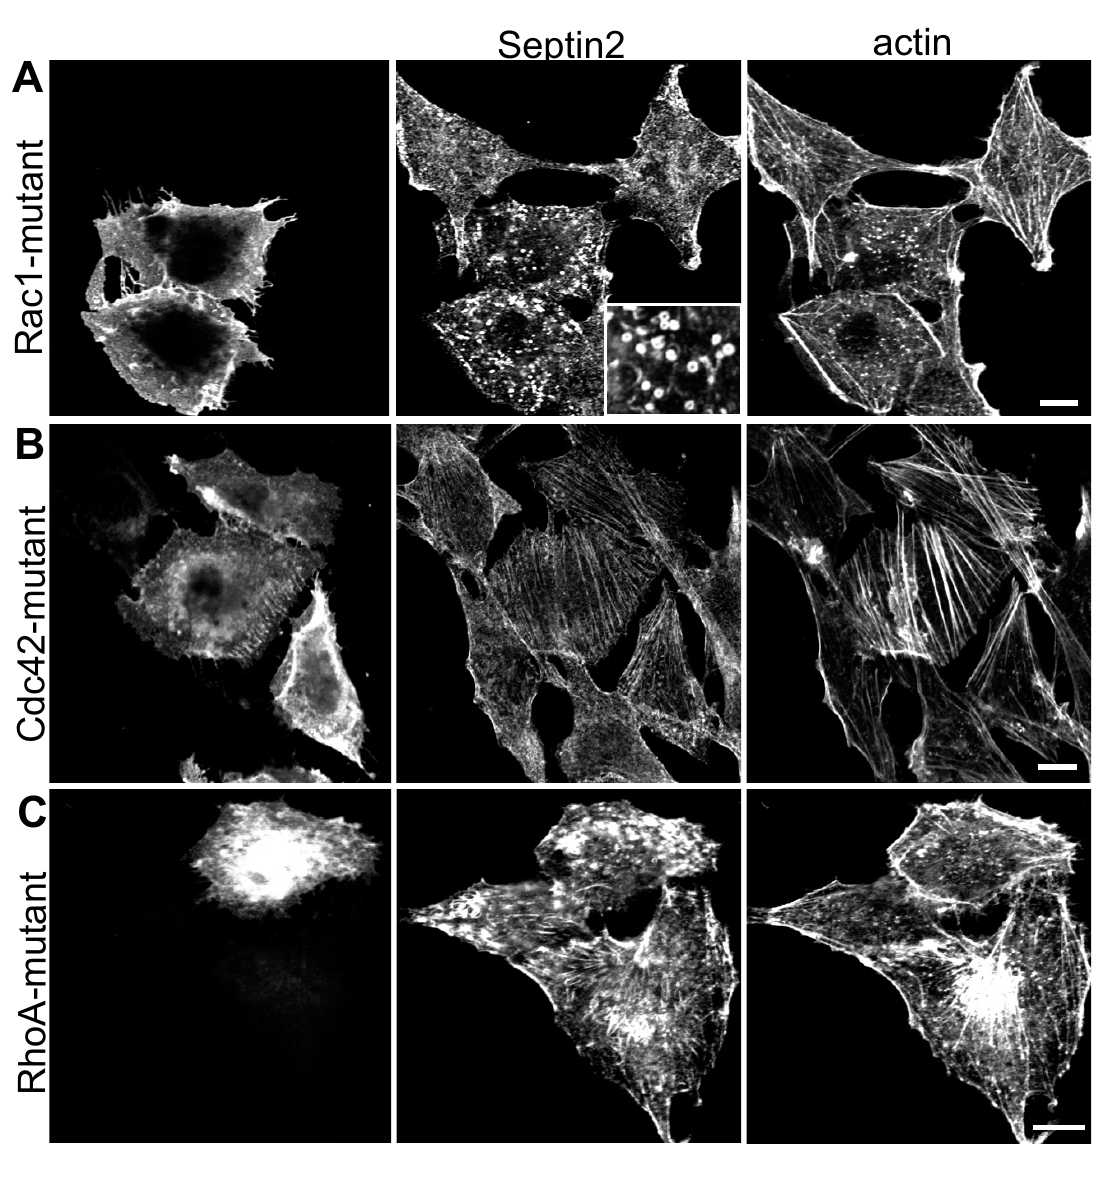
Figure 4 Effects of Rho-GTPases on actin and Septin2 organisation. NRK cells were transfected with GDP-locked forms of myc-Rac1 (A), myc-CDC42 (B) or myc-RhoA (C) and stained for Septin2 and actin. GTPases were detected with a monoclonal anti myc-antibody. (A) Cells expressing the myc-Rac1 mutant lack actin bundles and Septin2 organisation is disrupted. Instead of filaments, Septin2 forms rings (inset, inset was taken from another cell transfected with Rac1-mutant). (B) myc-CDC42-GDP induces the formation of thick actin bundles but has only little effect on Septin2 appearance. (C) Transfection with dominant- negativ myc-RhoA causes the detachment of most of the cells. Cells left on the coverslip have diminished actin filaments and disrupted Septin2 organisation. Images are single confocal sections. Bars, 10 µ